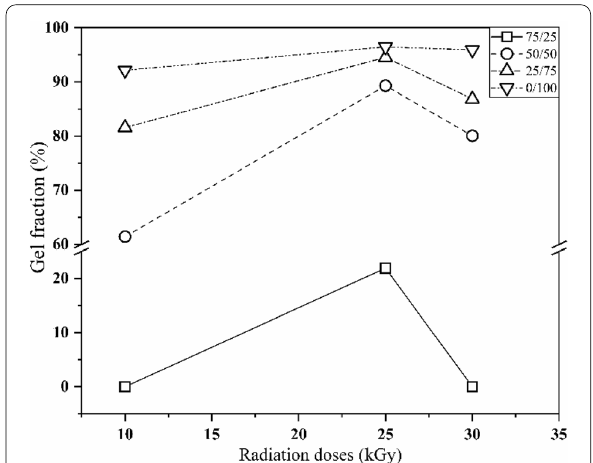
Fig. 1 Effect of irradiation dose on the gel fraction (%) of CS/PVA at different